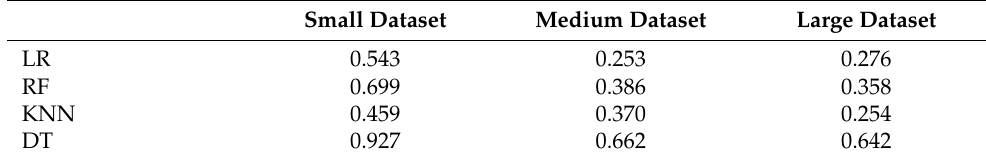
Figure 12. Standard deviation of MAE for 4 localization methods using the 3 RSS datasets. Table 10. Standard deviation of MAE results for the 4 tailored ML models using 3 different datasets.